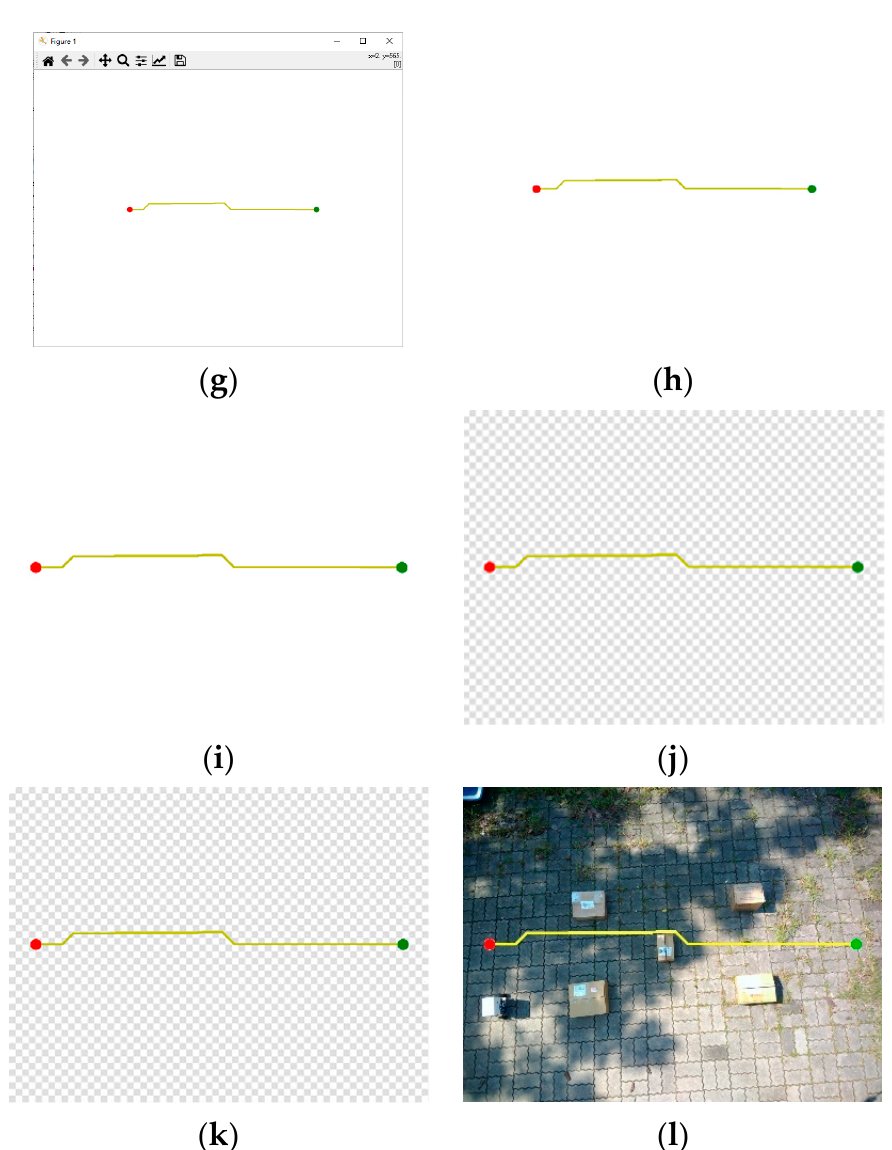
Figure 15. Intermediate output during path planning: ( a ) input an image; ( b ) down resolution path; ( c ) reduce saturation; ( d ) circle object; ( e ) binarized; ( f ) square border; ( g ) draw a path; ( h ) up resolution; ( i ) crop; ( j ) remove background; ( k ) restore resolution; ( l ) merge.